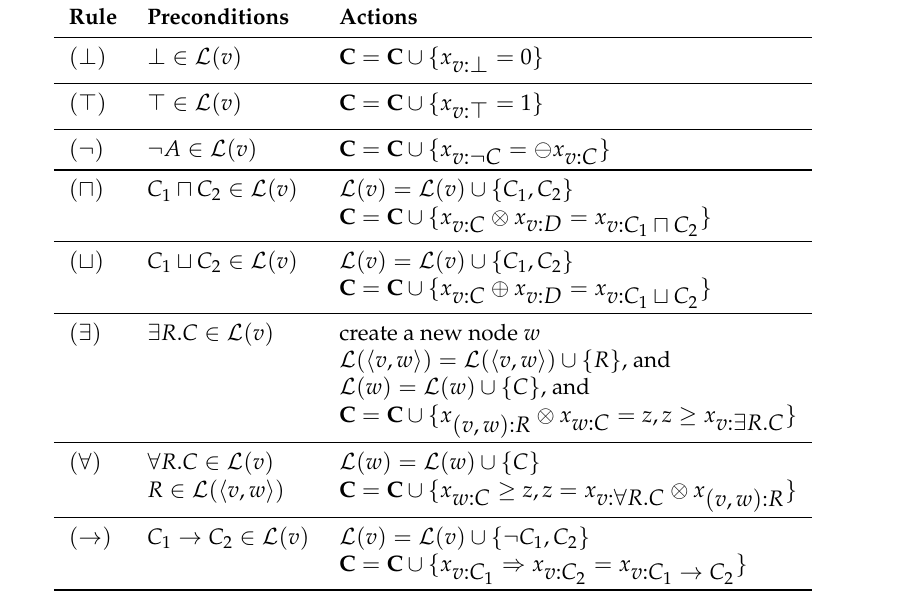
Table 3. Rules of the tableaux algorithm combined with an optimization problem [33].